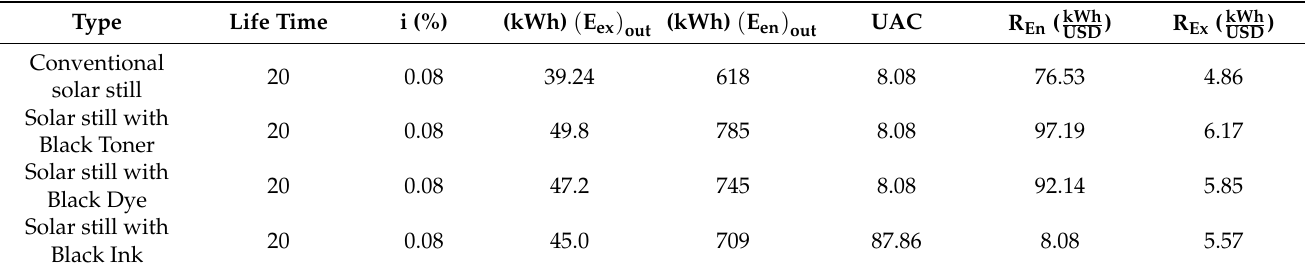
Table 6. Exergoeconomic parameter of different solar desalination.